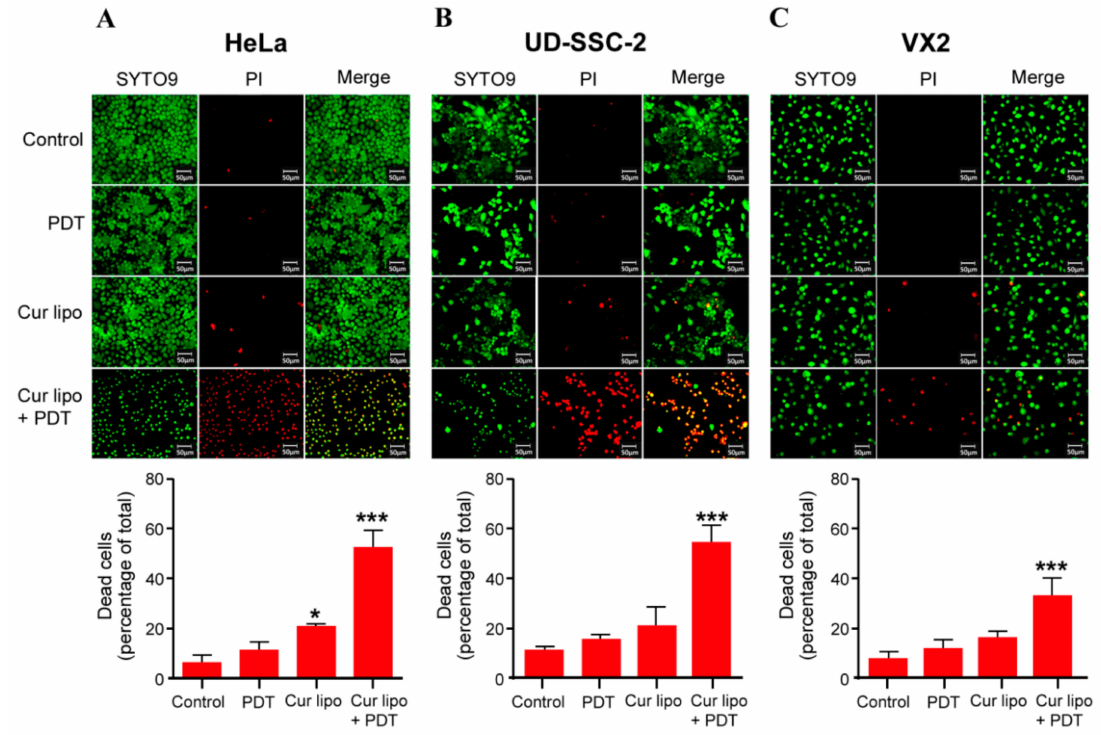
Figure 4. Live / dead staining of HeLa ( A ), UD-SCC-2 ( B ), and VX2 ( C ) cells. Cells were treated with photodynamic therapy (PDT) only, with curcumin liposomes (Cur lipo) only, or with Cur lipo in combination with PDT. Untreated cells were used as a control. All cells were stained with SYTO9 (green fluorescence) showing uniform green fluorescent nuclei, while propidium iodide (PI) only labeled nonviable or dead cells (red fluorescence) representing late apoptotic or necrotic cells. Bar graphs represent the quantification of dead cells (percentage) in the di ff erent treatment groups. Treated cells were compared to untreated control cells. The values are shown as mean ± standard deviation, and statistical significances are indicated as *** p < 0.001, * p <